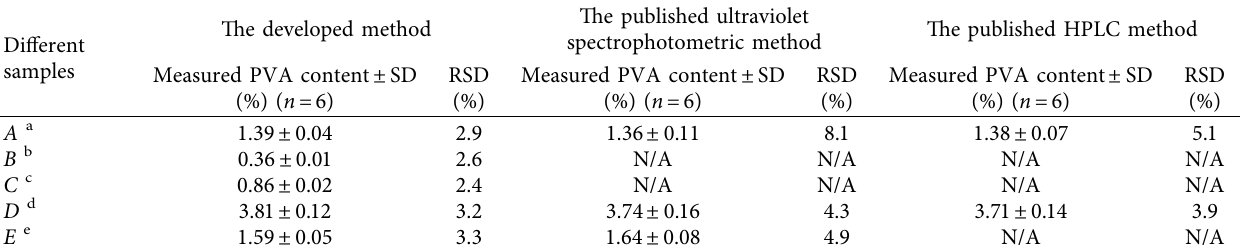
Table 6: Quantitative results of different samples using different analysis